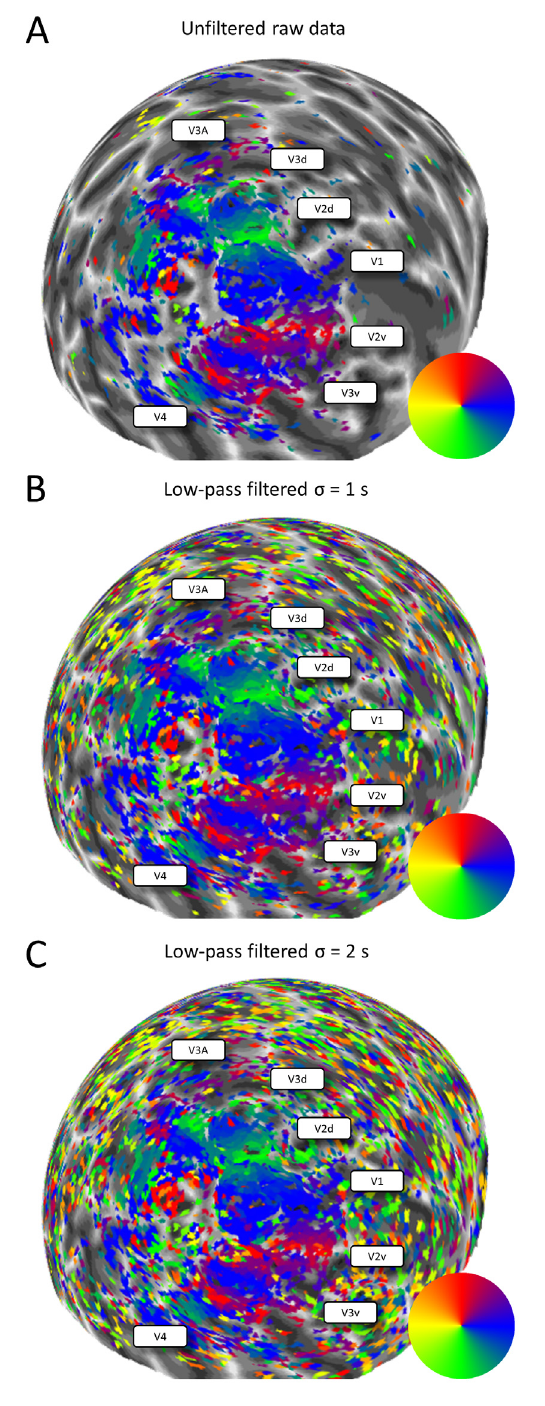
Figure 4. Polar angle maps of one participant from the Auckland 3T site displayed on a spherical model of the left hemisphere. Colour wheels denote the pseudo-colour code for visual field maps. No smoothing or interpolation was applied to the mapping data. Voxels were thresholded at R 2 >0.1. The position of the visual regions have been labelled for reference. The greyscale indicates the cortical folding pattern. A . Unfiltered data. B . Low-pass filtered with kernel 1 s. C . Low-pass filtered with kernel 2